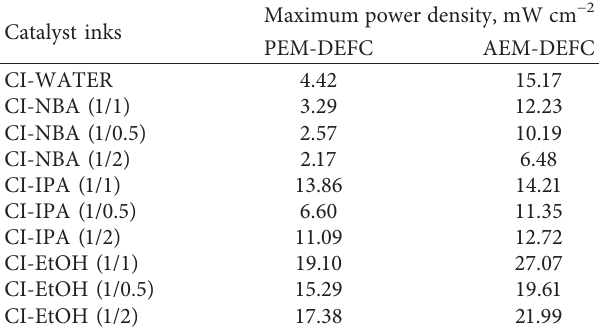
Table 3: Power density of DEFC with anode-coated different catalyst